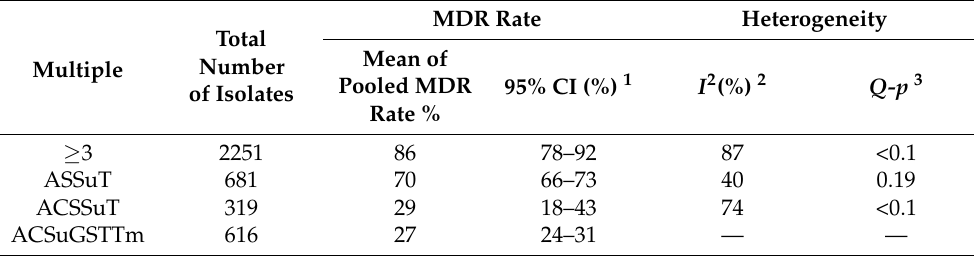
Table 2. Meta-analysis results concerning MDR rates in S . 1,4,[5],12:i:- isolates in China.